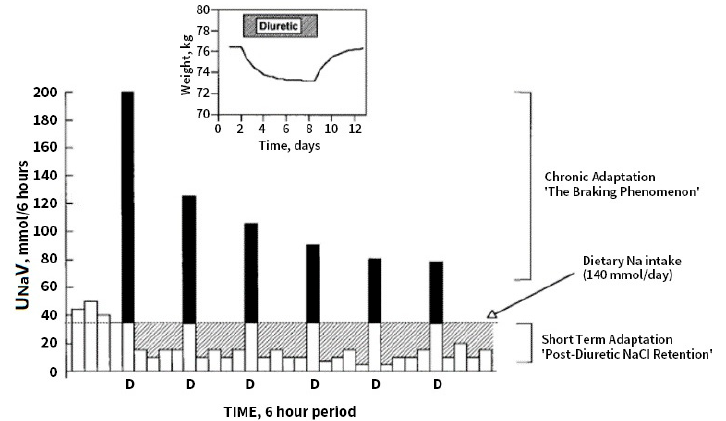
Figure 2. Effects of diuretics on urinary Na excretion and extracellular fluid (ECF) volume. Inset: effect of a diuretic on body weight, taken as an index of ECF volume. Bars represent 6-hour periods before (in Na balance) and after doses of loop diuretic (D). The dotted line indicates dietary Na intake. The solid portion of the bars indicates the amount by which Na excretion exceeds intake during natriuresis. The hatched areas indicate the amount of positive Na balance after the diuretic effect has worn off. Net Na balance during 24 h is the difference between the hatched area (postdiuretic NaCl retention) and the solid area (diuretic-induced natriuresis). After the first dose of the diuretic the excess natriuresis triggers a compensatory post-diuretic sodium reabsorption of equal magnitude, resulting in a net even sodium balance (compensatory post diuretic sodium reabsorption). With chronic administration of the same dose of diuretic, chronic adaptation is indicated by progressively smaller peak natriuretic effects (the braking phenomenon) and is mirrored by a return to neutral balance, as indicated in the inset, where the solid and hatched areas are equal. Note that steady state is reached within 6–8 days, despite continued diuretic administration. Reprinted with permission from Ref. [67]. 2022, Karger.